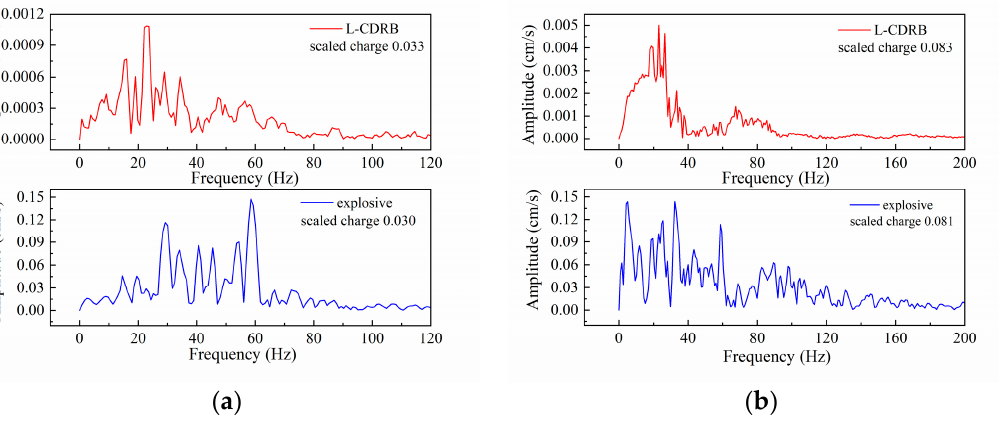
Figure 10. Frequency domain comparison of vibration velocities using different test methods: ( a ) scaled charge approach 0.03; ( b ) scaled charge approach 0.08.